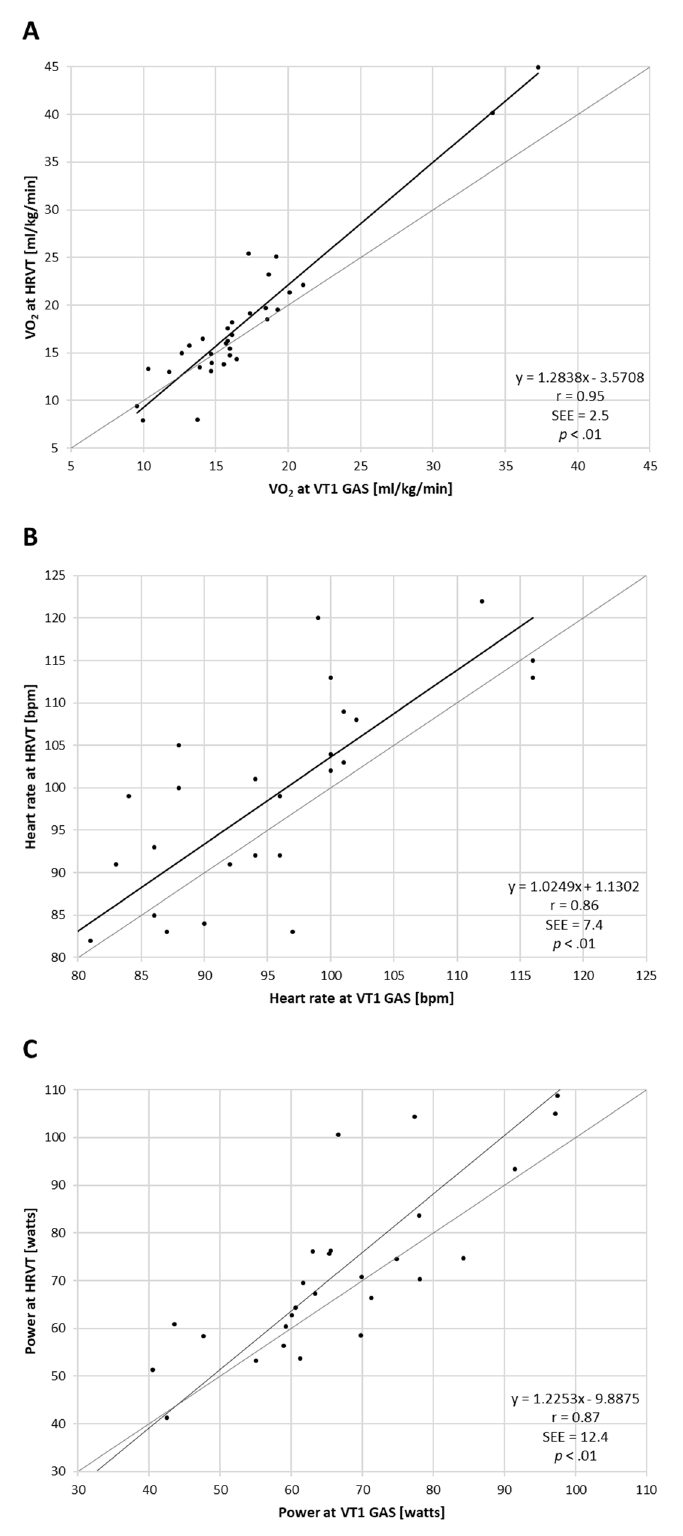
Figure 1. Regression plots for all participant ramp tests performed. ( A ) VT1 vs. HRVT for VO 2 ; ( B )